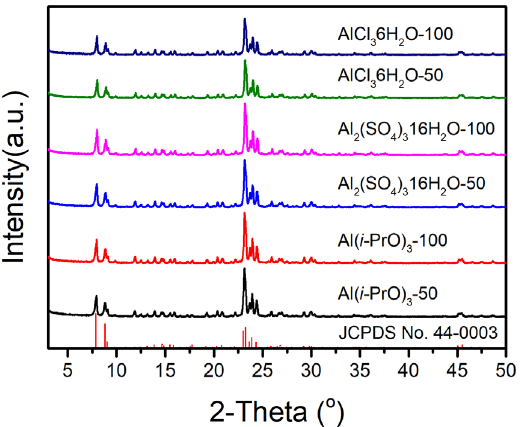
Figure 6. XRD patterns of ZSM-5 with Si/Al ratios of 50 and 100 synthesized with different Al sources.